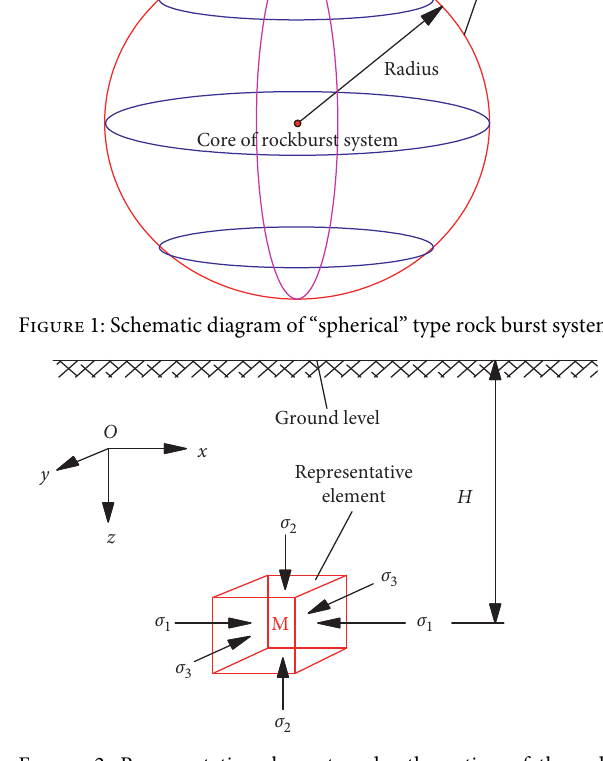
Figure 2: Representative element under the action of three-di- mensional